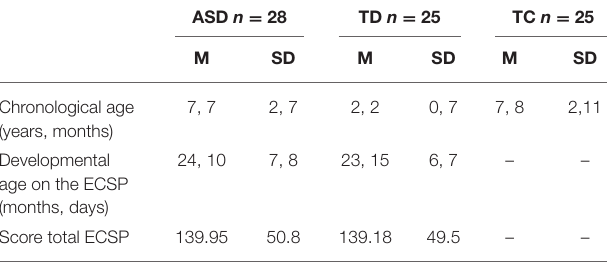
TABLE 1 | Participants’